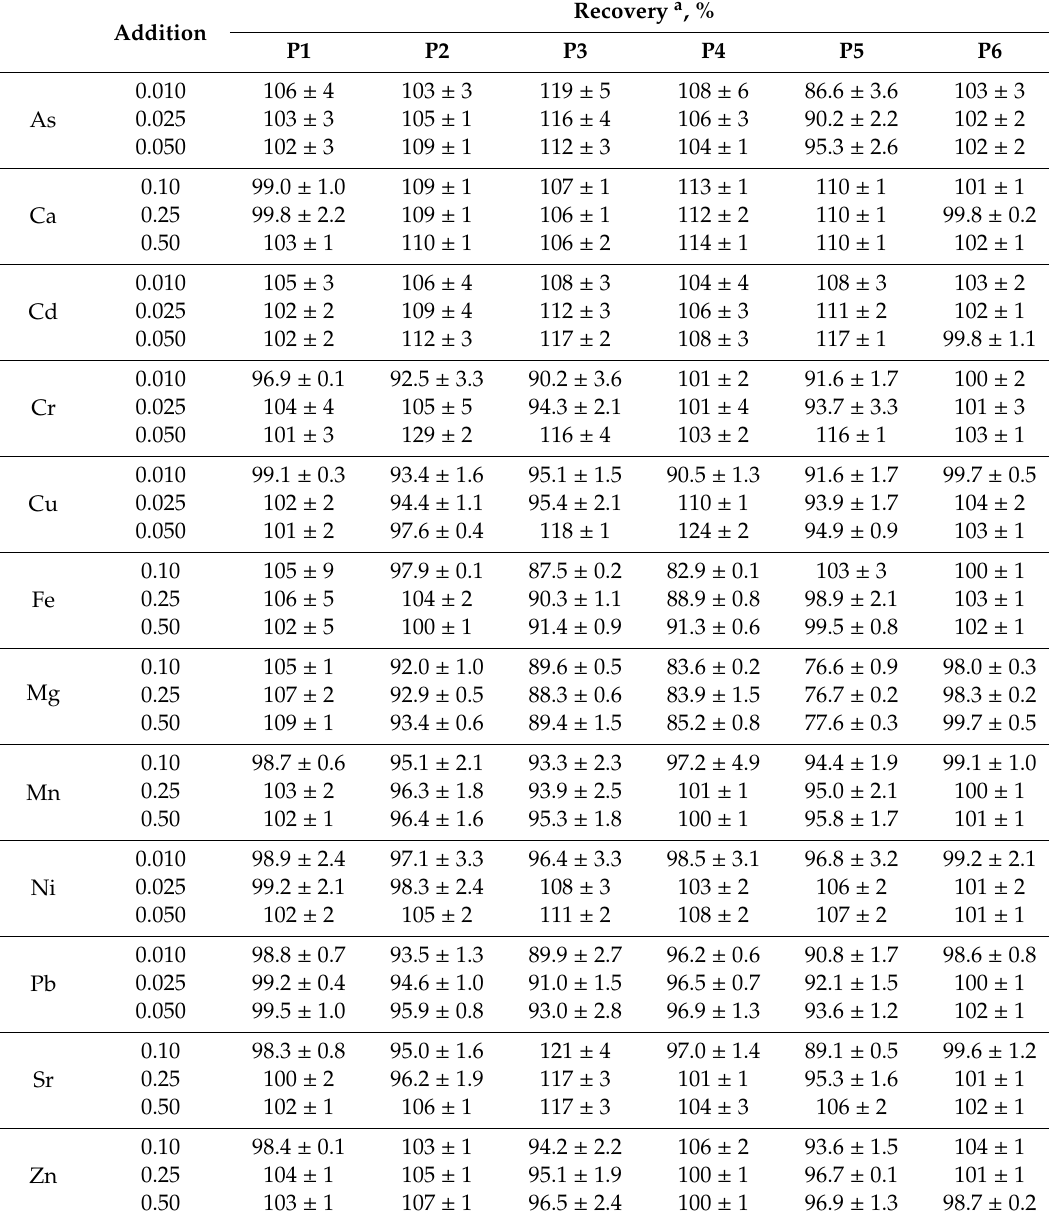
Table 4. Recoveries of elements in the selected birch sap (BS9) prepared prior to ICP OES analysis by using reference (P1) and alternative (P2–P6) sample preparation